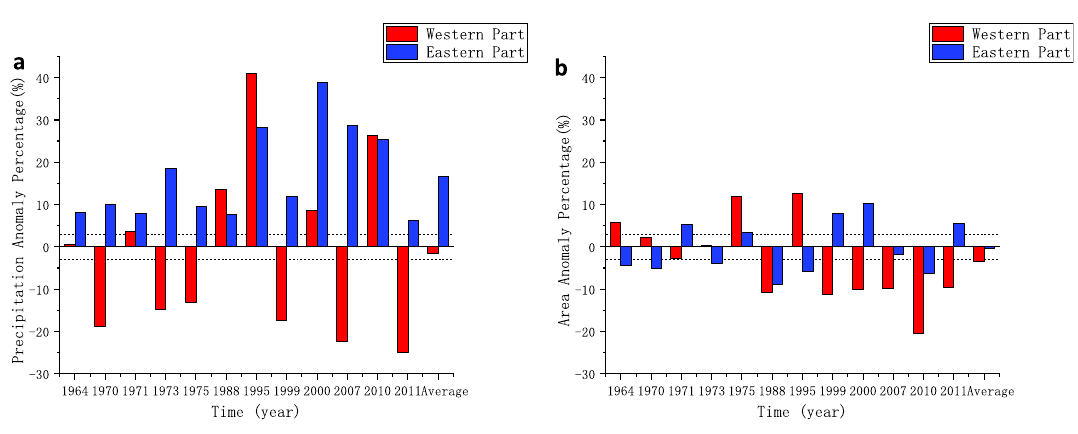
Figure 8. ( a ) Annual precipitation anomaly percentage and ( b ) area anomaly percentage in La Niña The average precipitation in La Niña years was 83.026 mm, and the average area of the arid region was 262.180 × 10 4 km 2 . The La Niña event increased the average precipitation in the arid region and reduced the area of the arid region. The anomaly percentage of precipitation and area of eastern and western arid region in La Niña years were calculated respectively and the result is shown in Fig. 8. In 6 of the 12 La Niña years, the area of the western and eastern arid region is smaller than the average. The precipitation in the western arid region is significantly smaller than the average in 6 years, and is bigger in 4 years. In the eastern arid region, the precipita- tion is bigger than the average in all 12 La Niña years. By using the linear regression method, the percentage of precipitation anomalies in the eastern part and the Niño 3.4 index were analyzed (R 2 = 0.58), and between the percentage of area anomalies and the Niño 3.4 in10dex, R 2 is 0.73. It indicates that the precipitation and area in the eastern arid region are related to La Niña. The same analysis was performed on the western arid region, and the correlations were not significant. Above results show that the La Niña events correlated with reduction in the